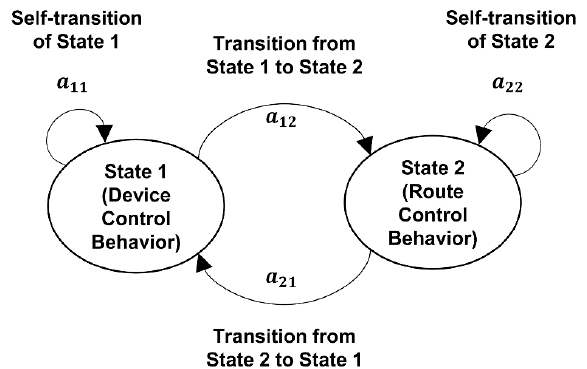
Figure 6. Graphical representation of the behavior model with a two-state ergodic hidden Markov model (HMM).